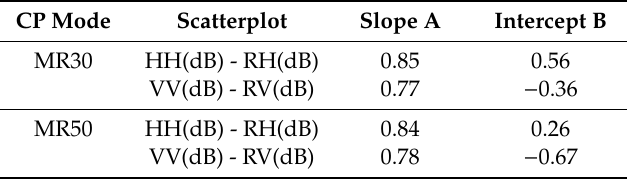
Figure 4. Scatterplots of RH (right circular-horizontal) and RV (right circular-vertical) intensities from simulated RADARSAT Constellation Mission (RCM) CP as a function of HH and VV intensities from RADARSAT-2 ( a – d ) scatterplots are in logarithmic scale and ( e – h ) scatterplots are in linear scale). Table 2. Transfer functions for pixels with conformity above 0.8.